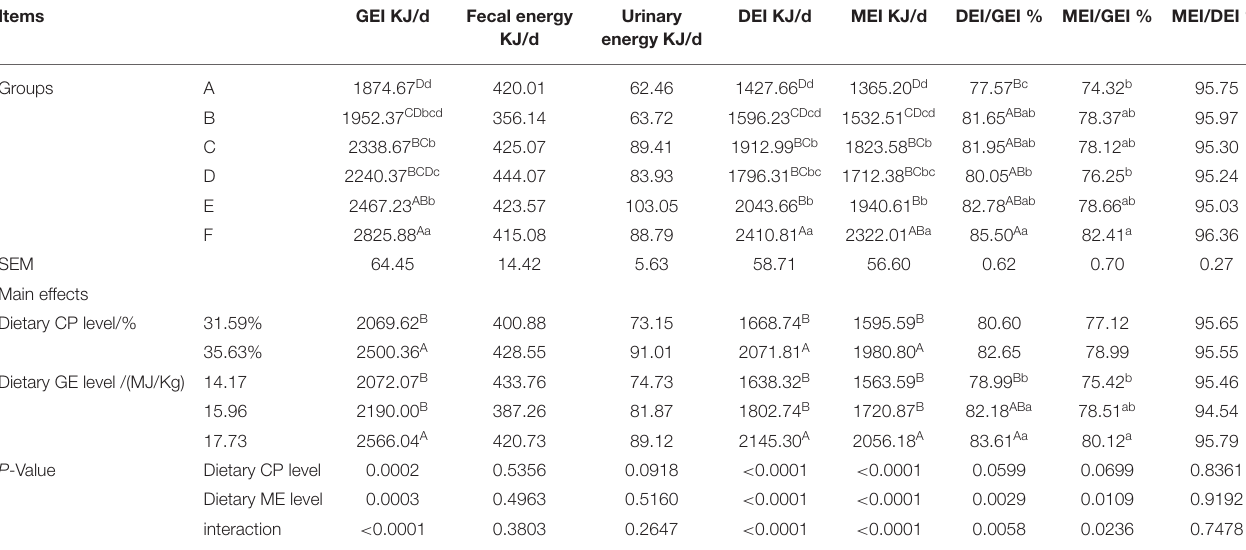
TABLE 6 | Effects of energy and protein levels on energy balance of mink during growing period.